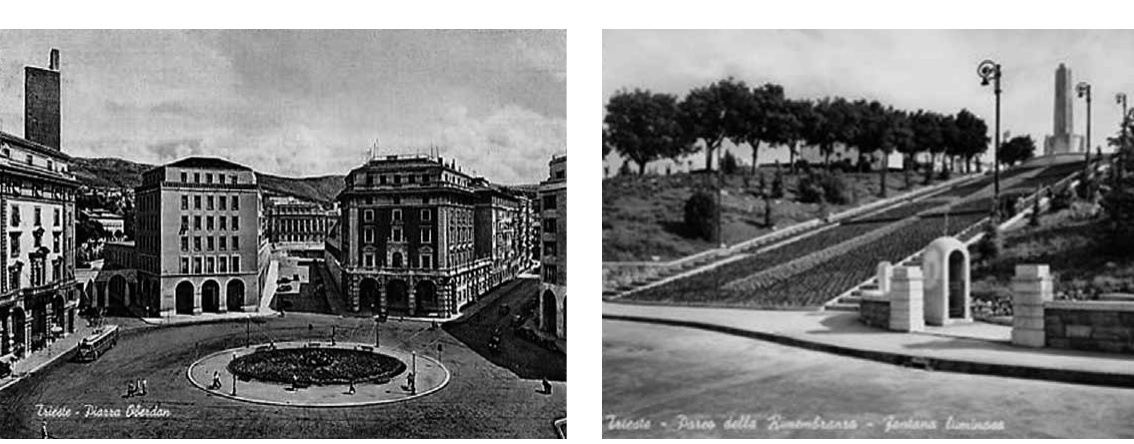
fig. 7. oberdan Square (photo by foto Stampa angeli, Terni) fig. 8. remebrance Park (photo by f. Brescia,